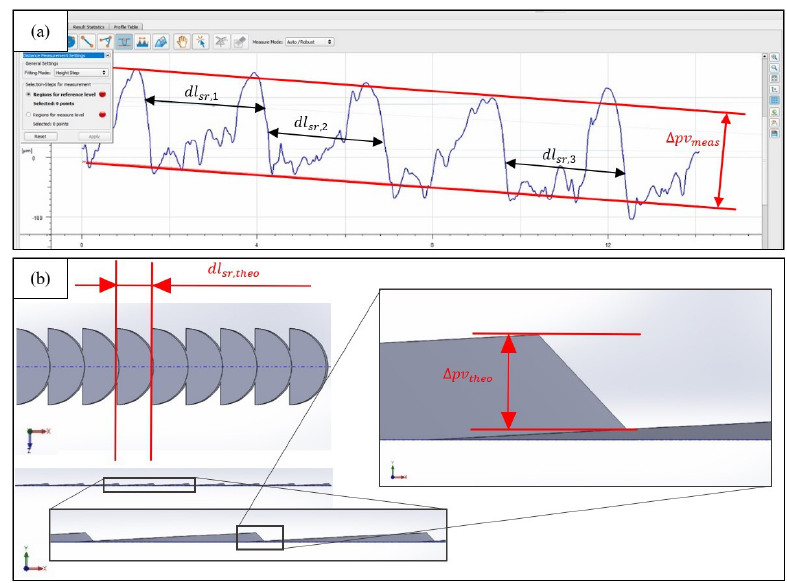
Figure 7. ( a ) Primary profile mean peak to valley distance (red) and scale to scale correspondent point distance (black) examples, ( b ) theoretical measures from scale pattern CAD